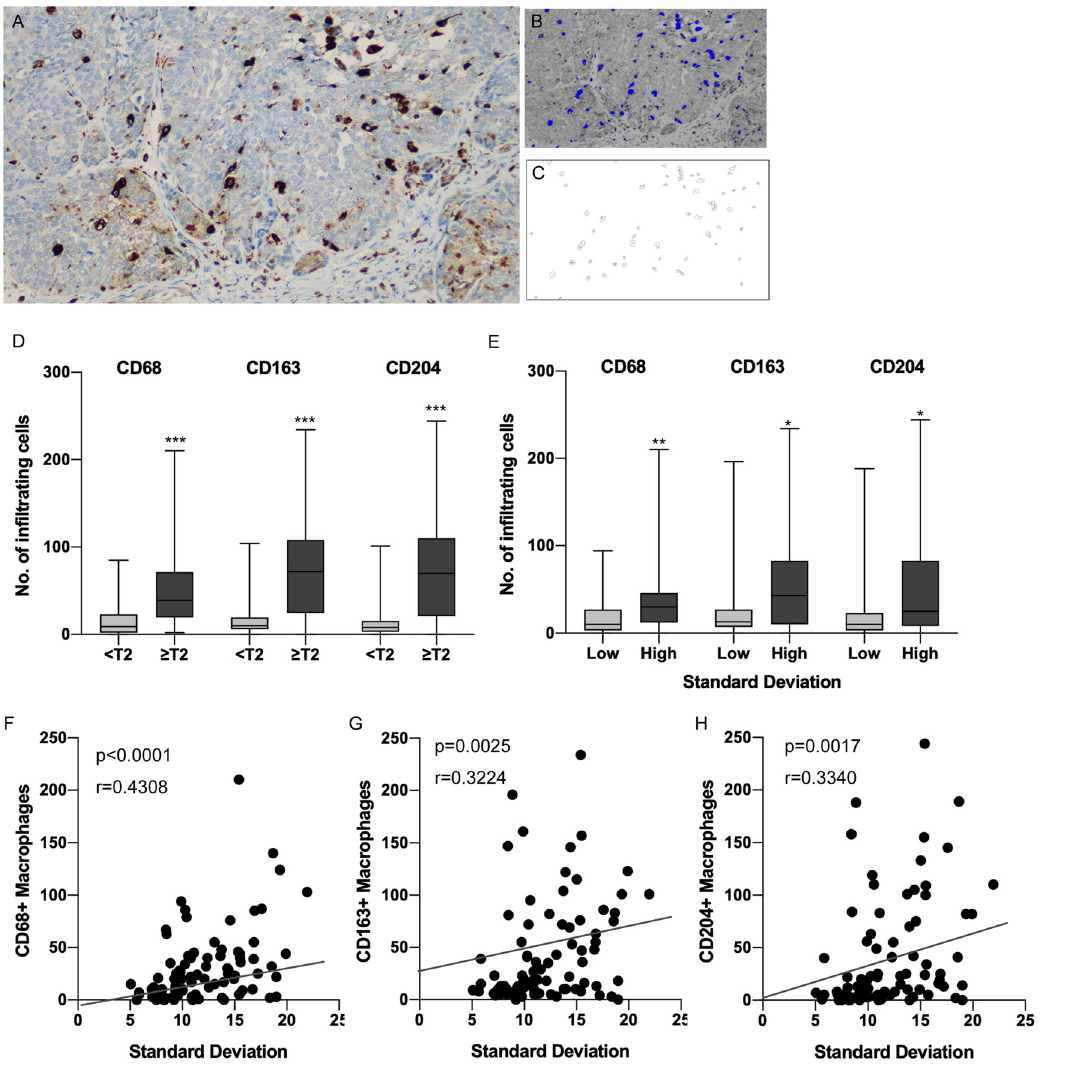
Figure 4. Tumors with heterogeneous internal texture in CT had more macrophage infiltration in UTUC. ( A ) Representative case of CD68 IHC that detected macrophages in muscle invasive urothelial carcinoma. ( B ) Image for detecting CD68-positive macrophages by the threshold using Image J software. Blue polygonal lesions indicate the CD68-positive macrophages. ( C ) Automatic counting of the number of infiltrating macrophages. ( D ) Boxplots for the number of infiltrating CD68-, CD163- and CD204-positive macrophages according to pathological T stage. ( E ) Boxplots for the number of infiltrating CD68-, CD163- and CD204-positive macrophages according to standard deviation obtained by TA. ( F ) Scatter plot comparing SD in TA and the number of CD68-positive macrophages. ( G ) Scatter plot comparing SD in TA and the number of CD163- positive macrophages. ( H ) Scatter plot comparing SD in TA and the number of CD204-positive macrophages. * p < 0.05, ** p < 0.001, *** p < 0.0001. CT = computed tomography, UTUC = upper tract urothelial carcinoma, IHC = immunohistochemistry, TA = texture